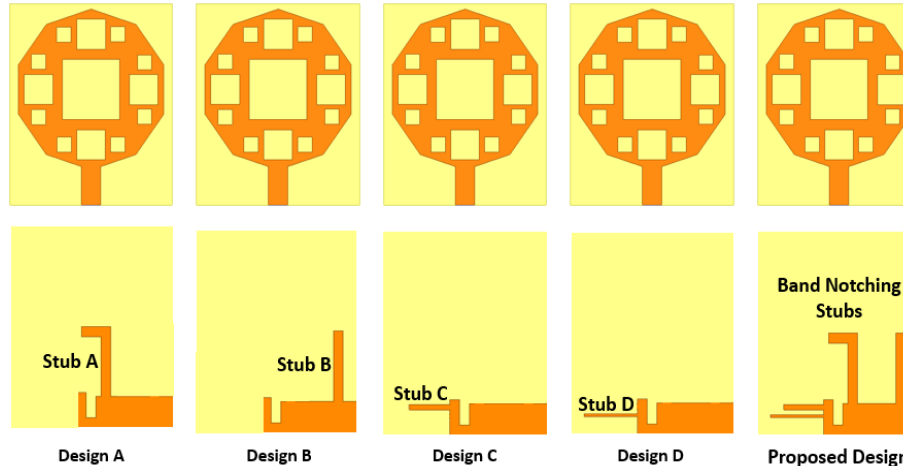
Figure 15. Progression stages.